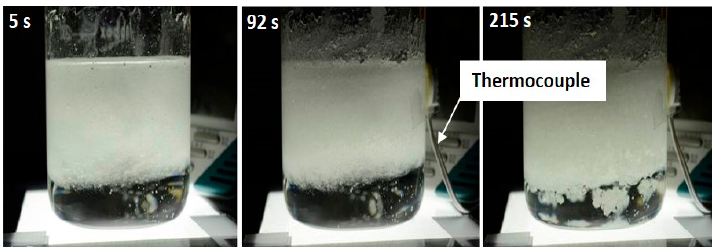
Figure 2. Snapshots of an undercooled Xylitol sample in a glass beaker at a starting temperature of T0 = 50 °C ( Δ T = 45 °C) after mechanical agitation. Observation of its crystallization after 5, 92, and 215 s.